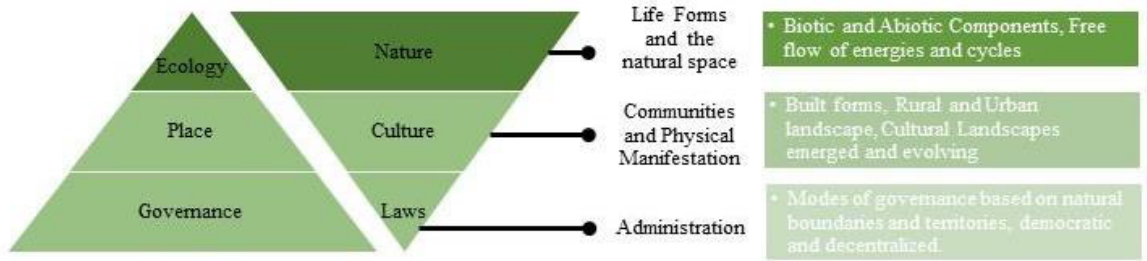
Figure 2 Diagrammatic representation of the summary of the theory of bioregionalism.